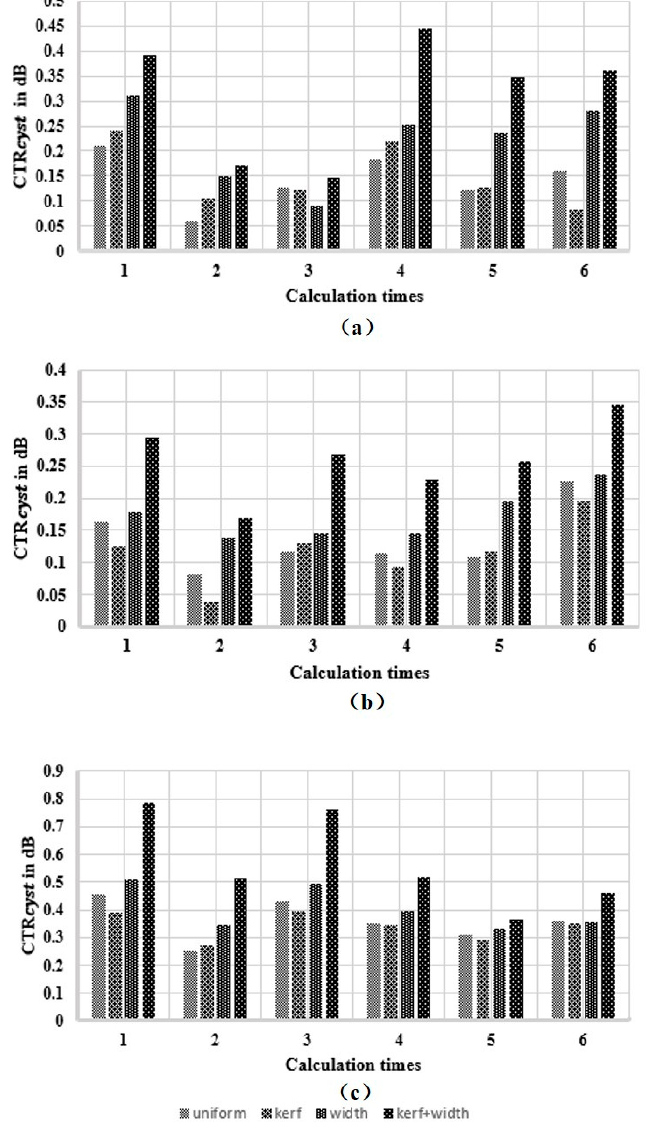
Figure 11. The contrast rations of the simulation results: ( a ) The cyst located at the depth of 5 mm, ( b ) the cyst located at the depth of 13 mm, and ( c ) the cyst located at the depth of 20 mm.